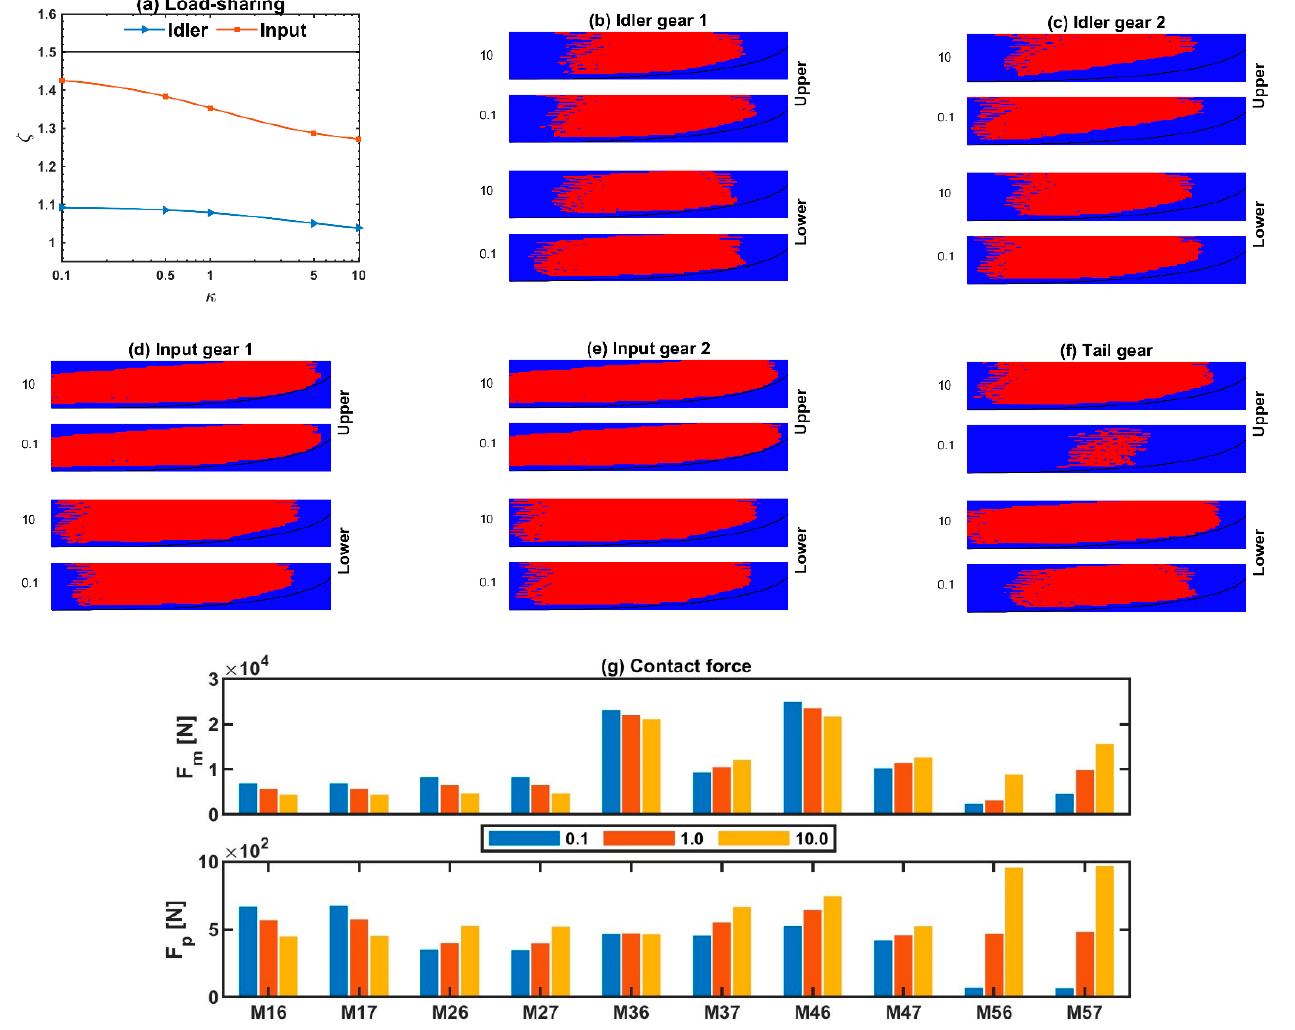
Figure 10. Influence of the support stiffness of the tail gear on the load-sharing and contact charac- teristics.